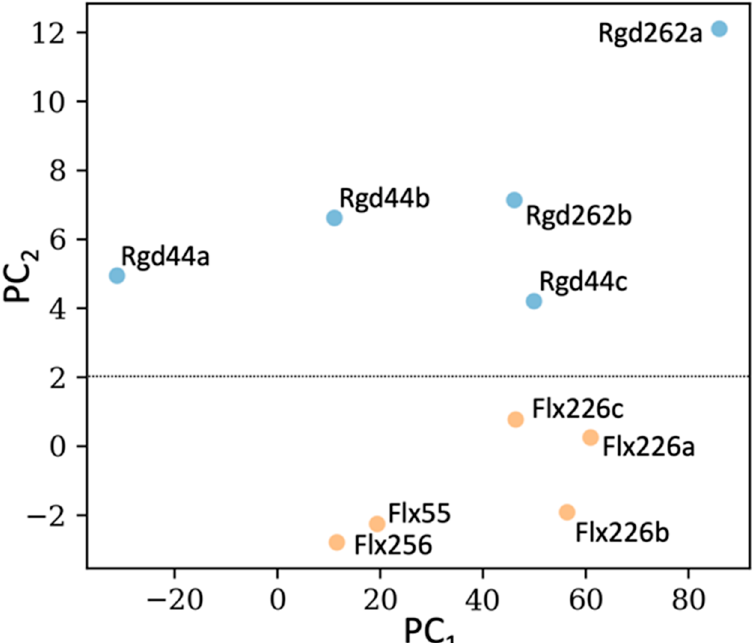
Figure 6. The dynamic distances are clustered for all characterized allosteric rigid (blue) and uncou- pled flexible (orange) designs. The weights of PC 1 and PC 2 are 250 and 30, respectively. The rigid designs and the flexible designs cluster separately. Designed proteins with similar MIC amp values, (Flx55 and Flx256), (Flx226c and Flx226a), (Rdg262b and Rdg44c) cluster in the same vicinity.